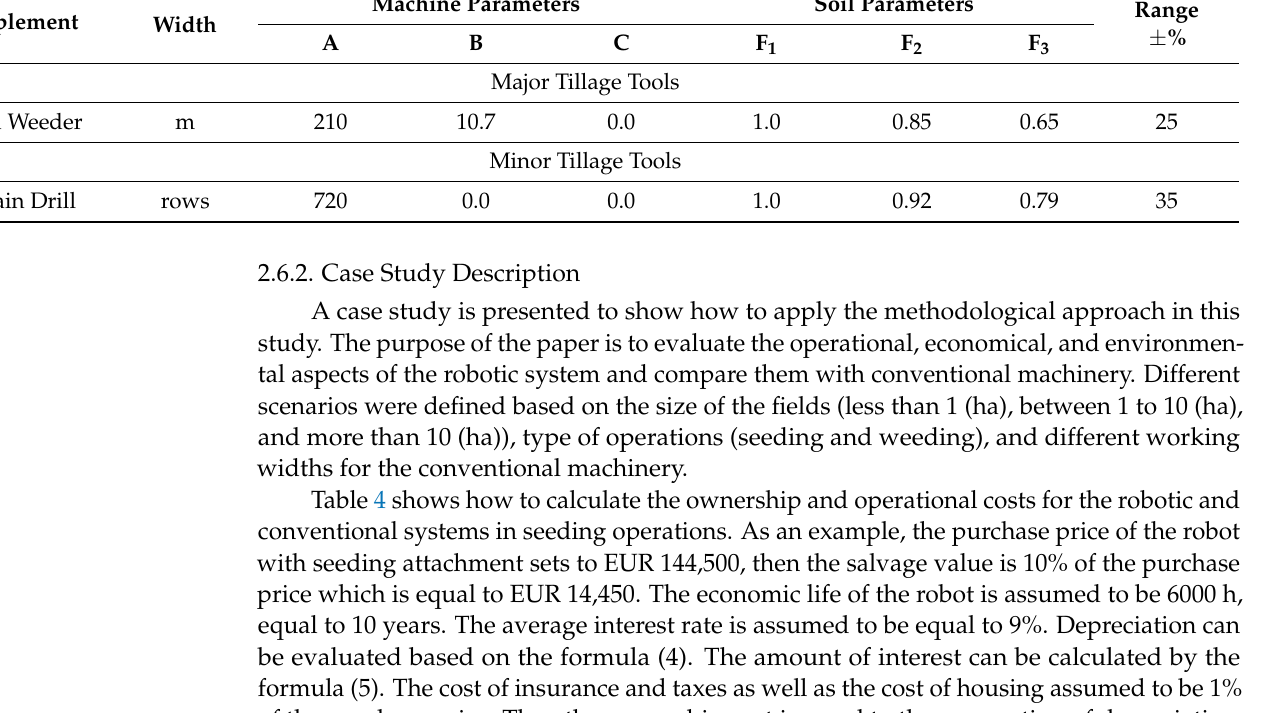
F i = dimensionless soil texture adjustment parameter; i = 1 for fine, 2 for medium, and 3 for coarse-textured soils; A , B , and C = machine-specific parameters; S = field speed (km/h);